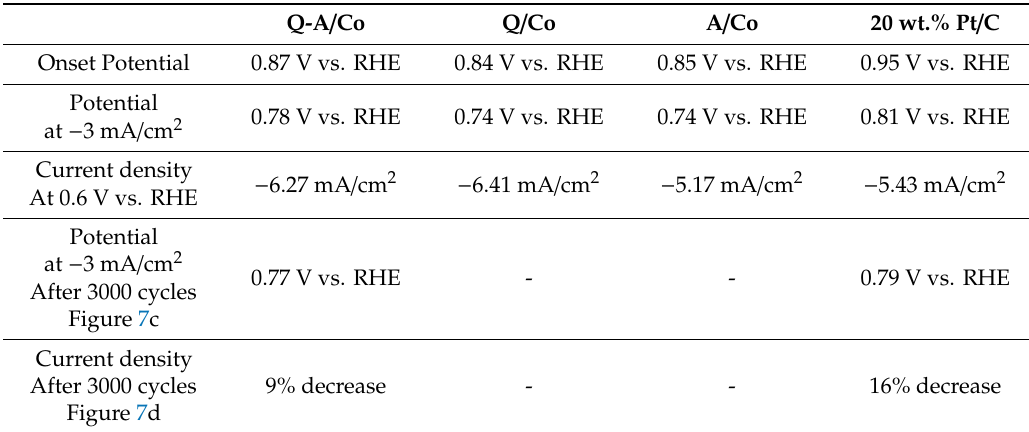
Table 3. Summary of the electrochemical catalytic activity of Co-N-doped carbon and 20 wt.% Pt / C.